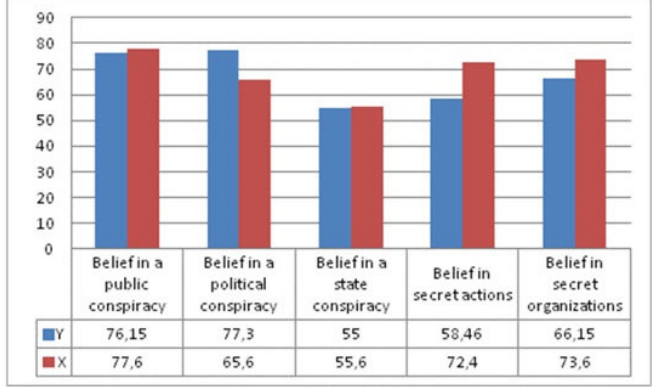
Figure 1. Indicators of faith in conspiracy of